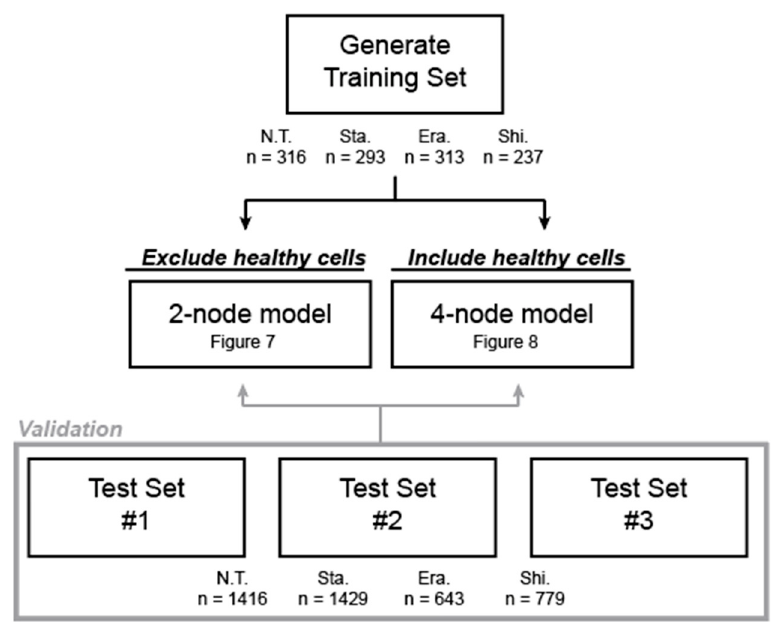
Figure 1. Schematic of study design. In four independent experiments, 501mel cells were treated with DMSO (not treated, N.T.), staurosporin (Sta.), erastin (Era.) or shikonin (Shi.). One experiment was designated the Training Set and used to generate two classification models—one to distinguish the form of programmed cell death among dying cells and one to distinguish the form of programmed cell death and healthy cells. The reproducibility of both models was tested with the remaining datasets.